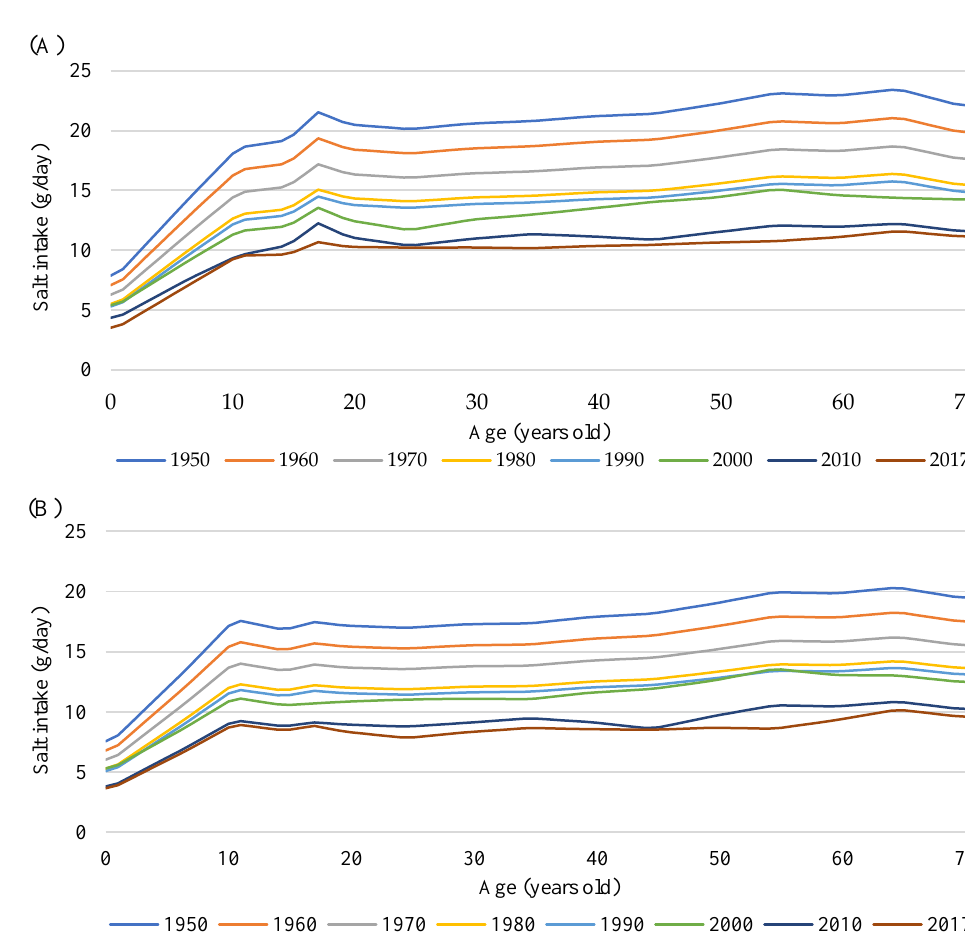
Figure 2. Age-specific average salt intake in selected years in men ( A ) and women ( B ), estimated from National Nutrition Surveys between 1973 and 2002 and National Health and Nutrition Surveys between 2003 and 2017.